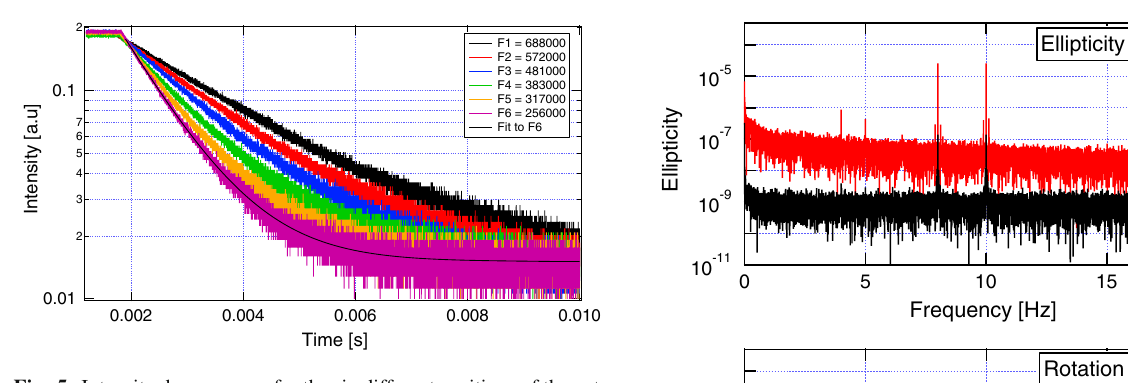
Fig. 5 Intensity decay curves for the six different positions of the gate valve clipping the beam to increases the losses inside the cavity. F1–F6 represent the relative finesse values. As an example, an exponential fit is superimposed to the curve relative to F6